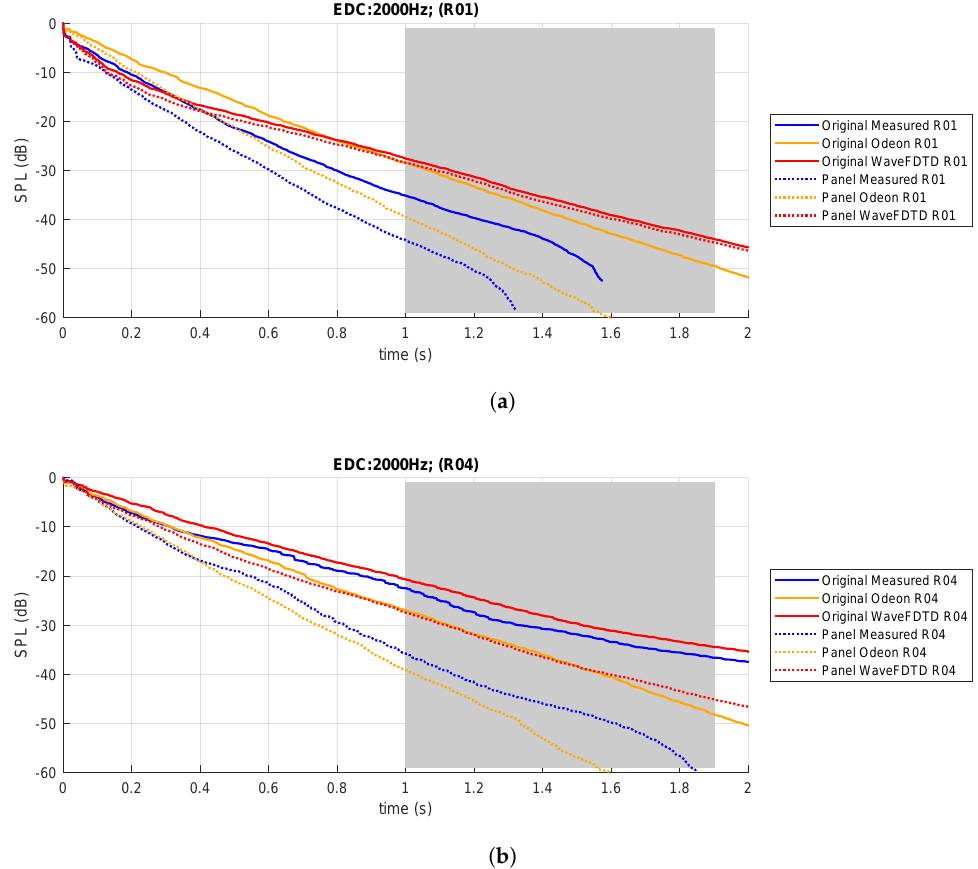
Figure 11. Energy decay curves for measured and modeled data before and after acoustical remediation. ( a ) Receiver located off the aisle 3 m from source, ( b ) receiver located on the aisle 3 m from source. Highlighted area reflects the data used for wavelet MRA in Sections 3.4.1 and